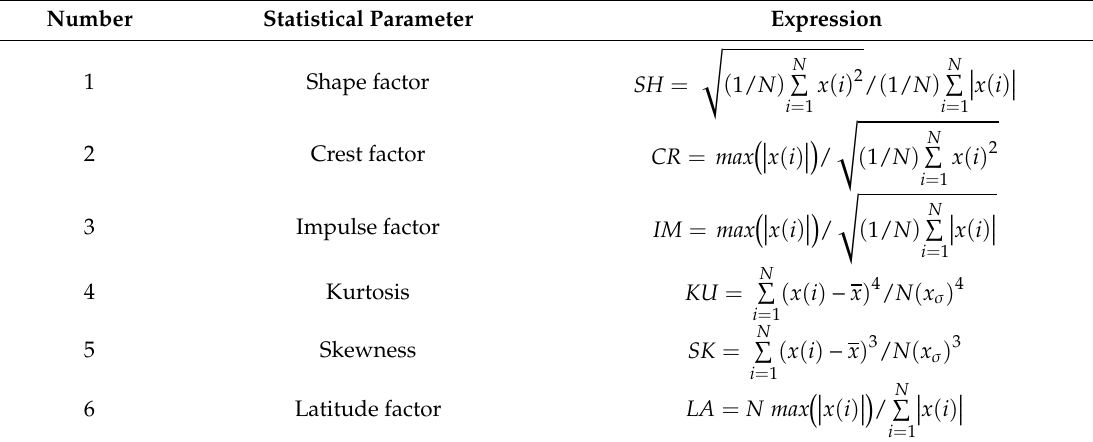
Table 4. Statistical methods of IIM selection.